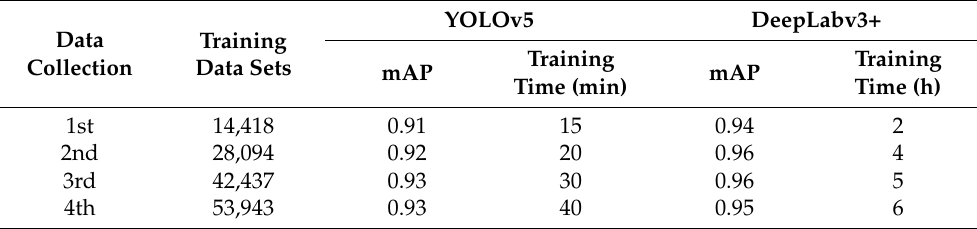
Table 10. The mAP results of YOLOv5 and DeepLabv3+ by data collection period for